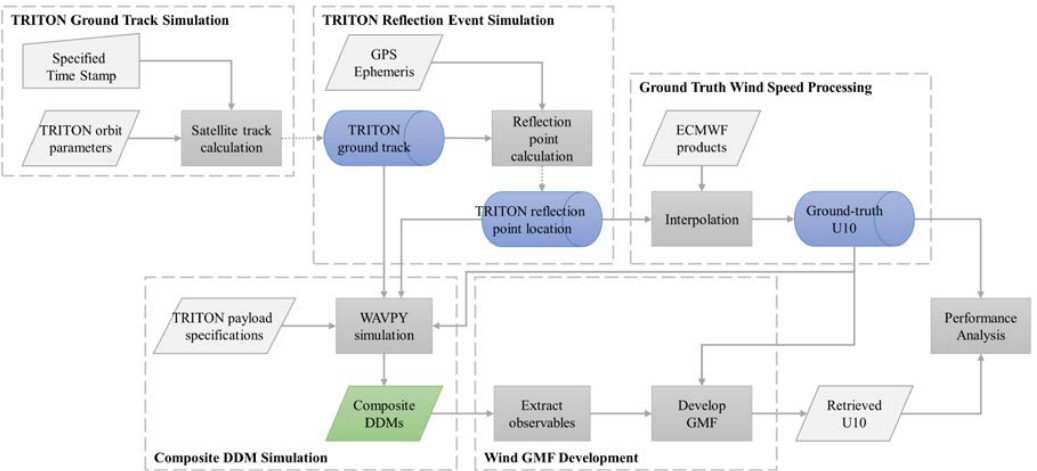
Figure 11. Overall research flow diagram, including the simulation of the TRITON ground track and corresponding reflection events, the proposed GNSS-R measurements and the observables, and the ground truth data generated for the performance evaluation.